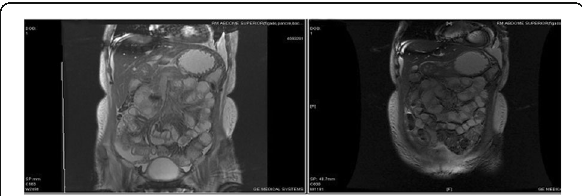
Fig. 1 (abstract P111). MRI enterography showing diffuse intestinal and colonic loops distension, diffuse thickening of this last one, in addition to mild enanthematous gastritis and severe erosive